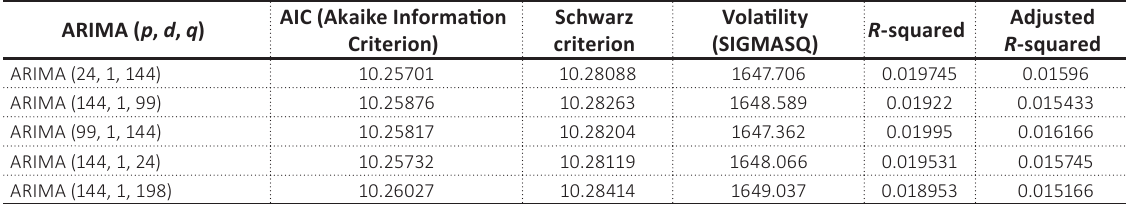
Schwarz Volatility R -squared Adjusted (SIGMASQ) R Criterion) criterion